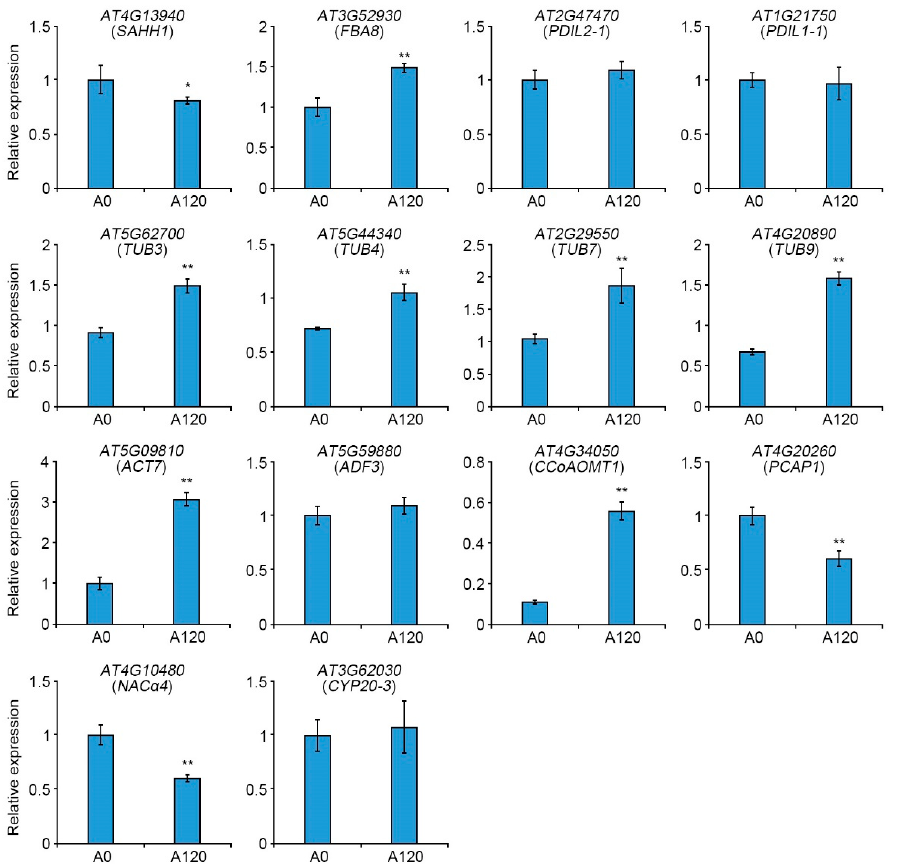
Figure 5. Transcript levels of cell structure-related genes in control (A0) and salt-adapted (A120) cells. Total RNAs were extracted from the A0 and A120 cells. Transcript levels were determined by quantitative real-time PCR (qRT-PCR). UBQ10 was used as a quantitative control for qRT-PCR. Error bars represent the standard deviation (SD) of three independent replicates. Asterisks indicate significant differences in the A0 cells (* p -value < 0.5; **, p -value ≤ 0.01, Student’s t-test).